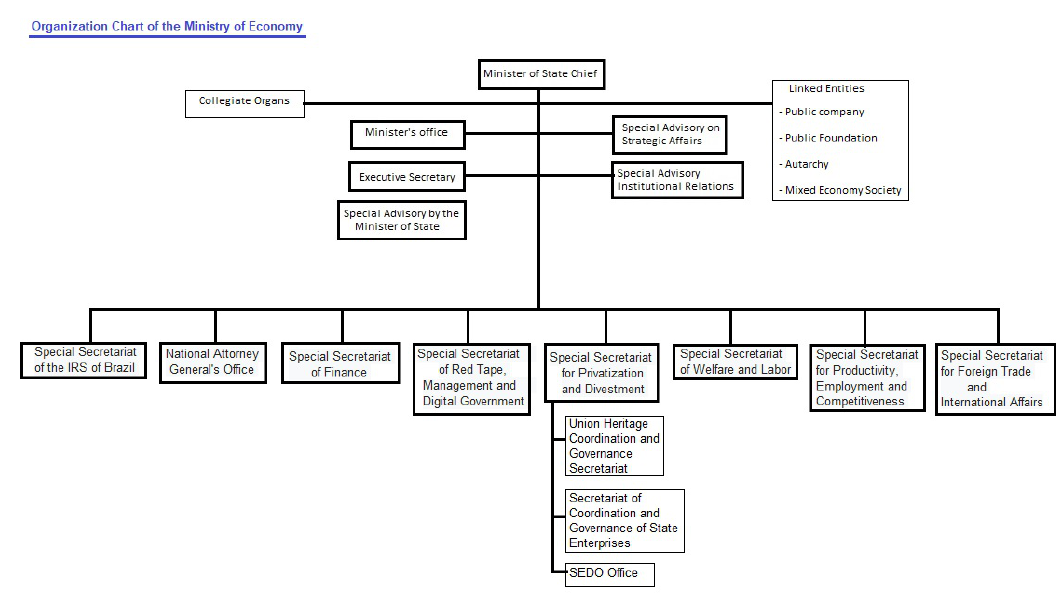
Figure 1. Organizational structure of the brazilian public